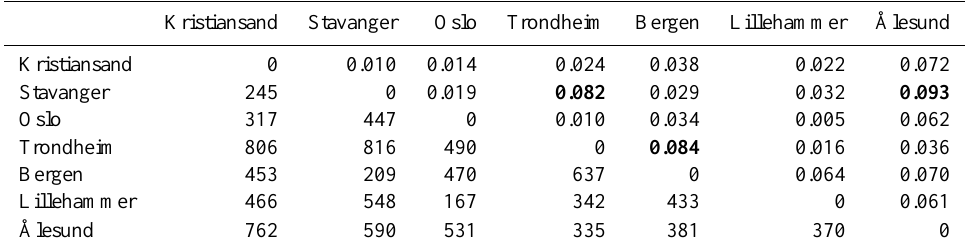
Figure 6. (a) Link-failure likelihood and (b) total additional traffic load per road closure; main routes between seven large cities in southern Norway are marked in yellow. Table 1. Matrix of distances on main routes (km) between major cities (lower left) and the associated total path-failure likelihood (event/year) (upper right); cells are highlighted in bold according to quartile-based classification of failure